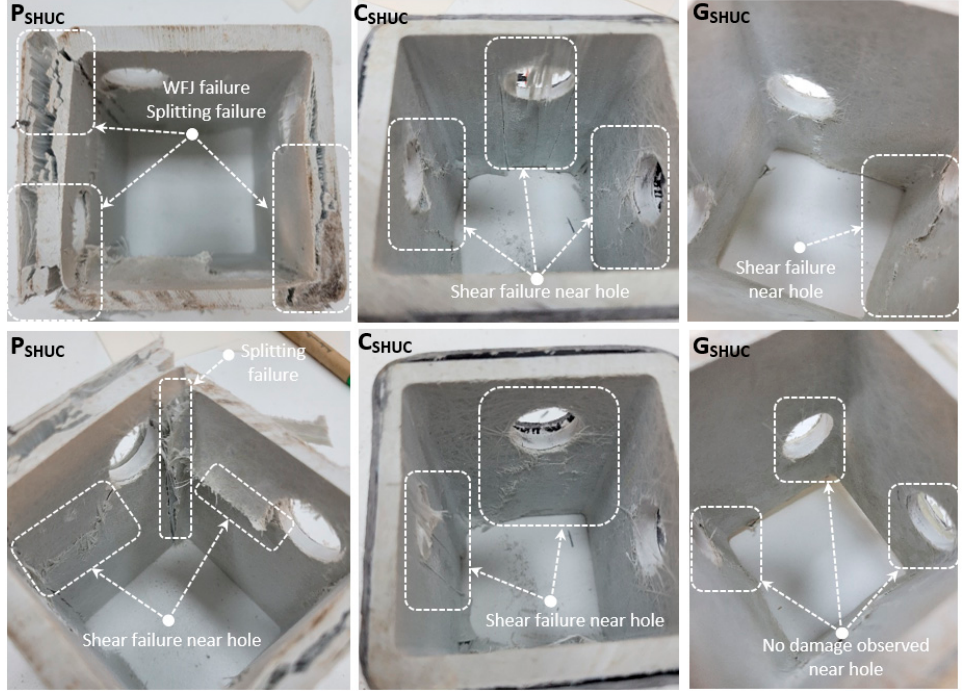
Figure 6. Damage analyses of P SHUC , C SHUC , G SHUC .